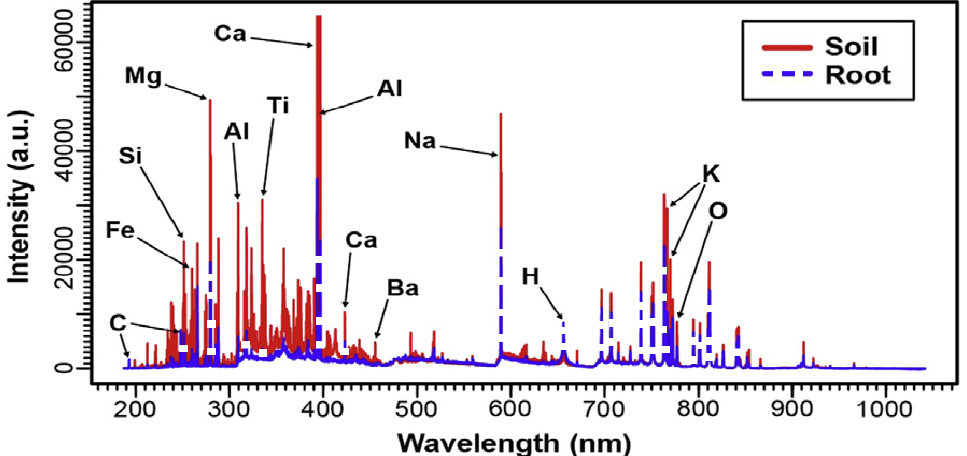
Figure 1. Representative broadband laser-induced breakdown spectroscopy (LIBS) spectra of single soil and root ablations with characteristic elemental peaks identified. Signal intensity values are in arbitrary units (a.u.). Reprinted from Soil Biology and Biochemistry, 131, [12]. High-resolution elemental mapping of the root-rhizosphere-soil continuum using LIBS, 119–132. Copyright 2019, with permission from Elsevier.